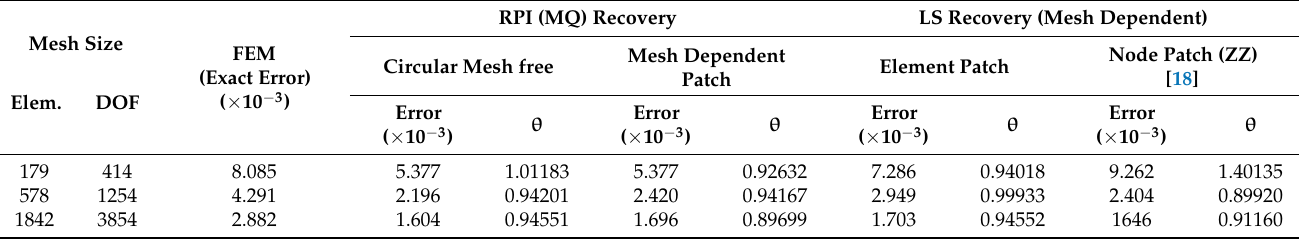
Table 13. Error convergence and global effectivity ( θ ) for plate problem with hole using RPI (MQ) and least square based recovery techniques (quadrilateral, energy norm).